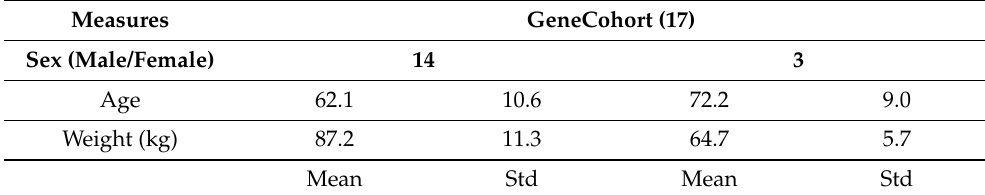
Table 3. Characteristics of the cohort of GeneCohort images used in this contribution. Measures GeneCohort